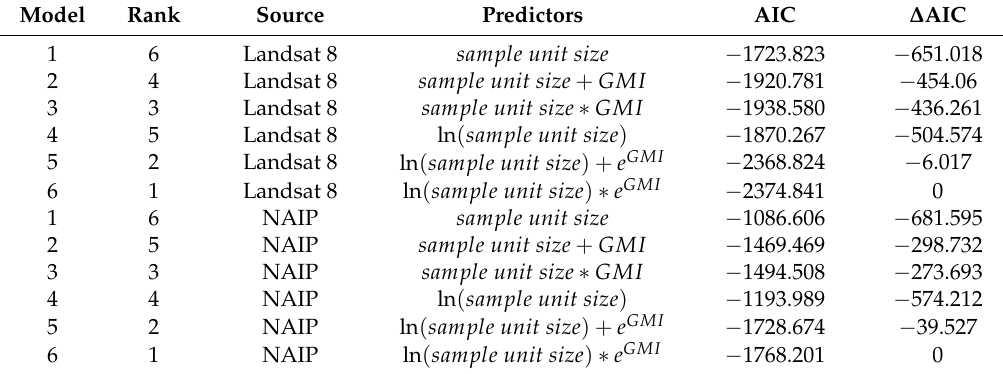
Table 4. Beta regression coefficients and statistics for top fitting Landsat 8 and NAIP based images given natural log sample unit size (LSS), exponent of global Moran’s index (EGMI), interaction between LSS and EGMI, and simulated average co-registration